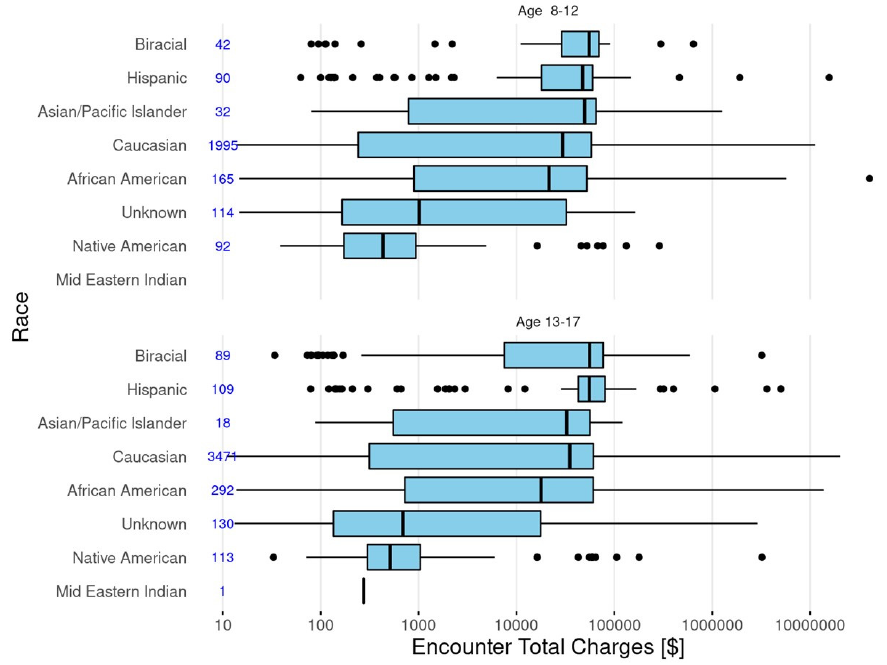
Figure 3. Distribution of total patient charges across races/ethnicity for children (8–12 years of age) and adolescents (13–18 years of age).